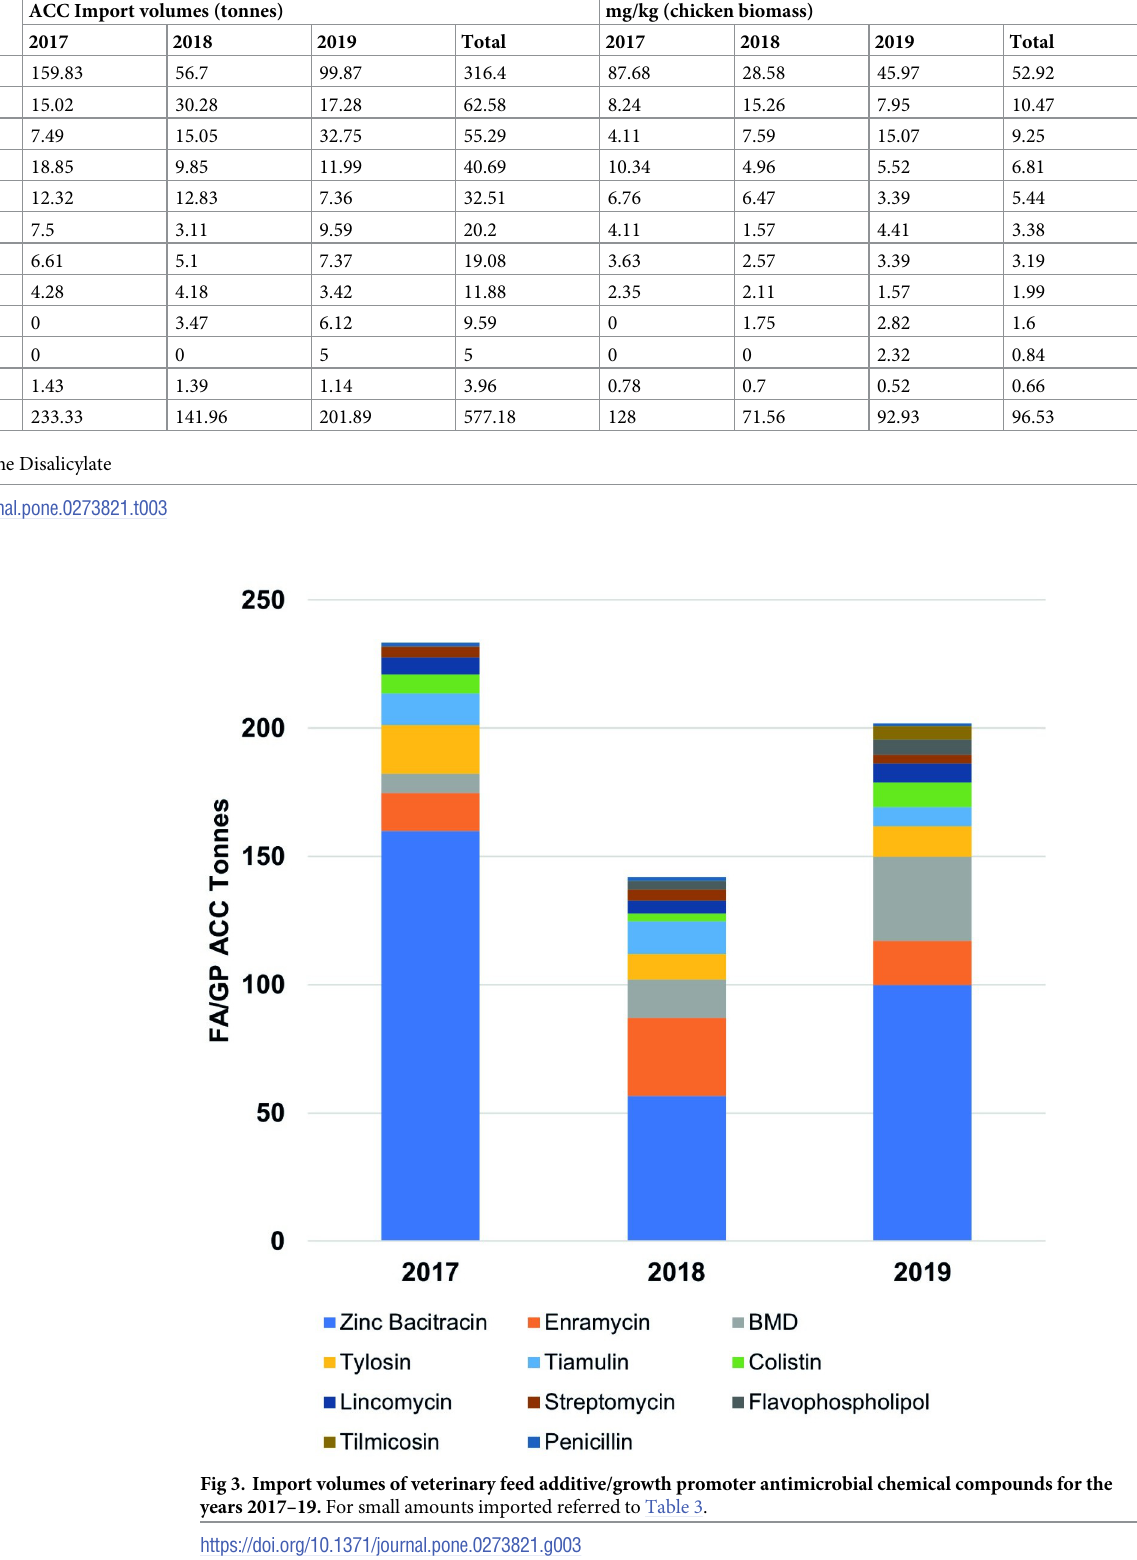
Table 3. Antimicrobial chemical compounds import volumes for poultry feed additives/growth promoters for the years 2017–19. Antimicrobial